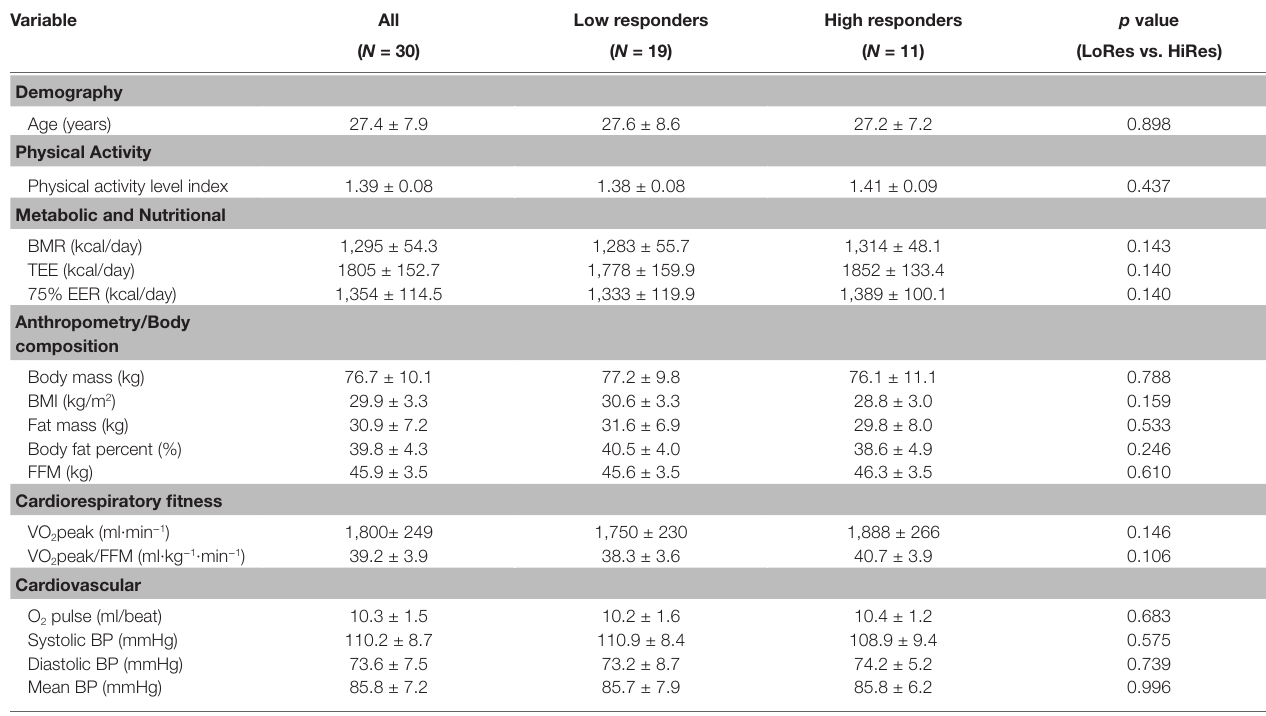
TABLE 1 | Baseline demographic, physical, and physiological characteristics of the participants. Variable